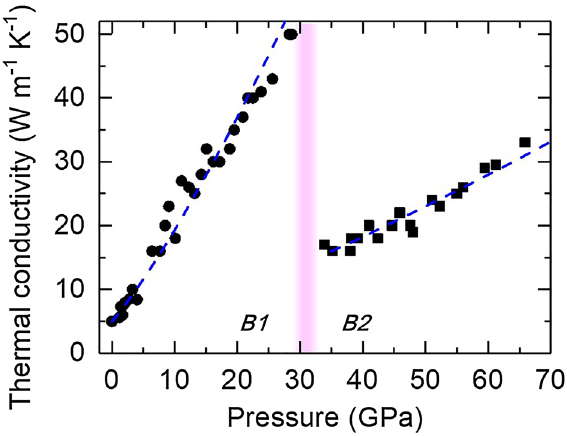
Figure 1. Pressure dependence of the thermal conductivity of NaCl at room temperature. In B1 phase, the thermal conductivity increases rapidly with pressure, while drops upon the B1–B2 transition around 30 GPa (pink shaded region). The increasing rate of thermal conductivity with pressure in the B2 phase is smaller than that in the B1 phase. The experimental uncertainties are typically ~ 20% before 30 GPa and ~ 20–30% at 30–66 GPa. Blue dashed curves represent the predicted thermal conductivity by the LS equation which describes well the data for both B1 and B2 phase (see text for